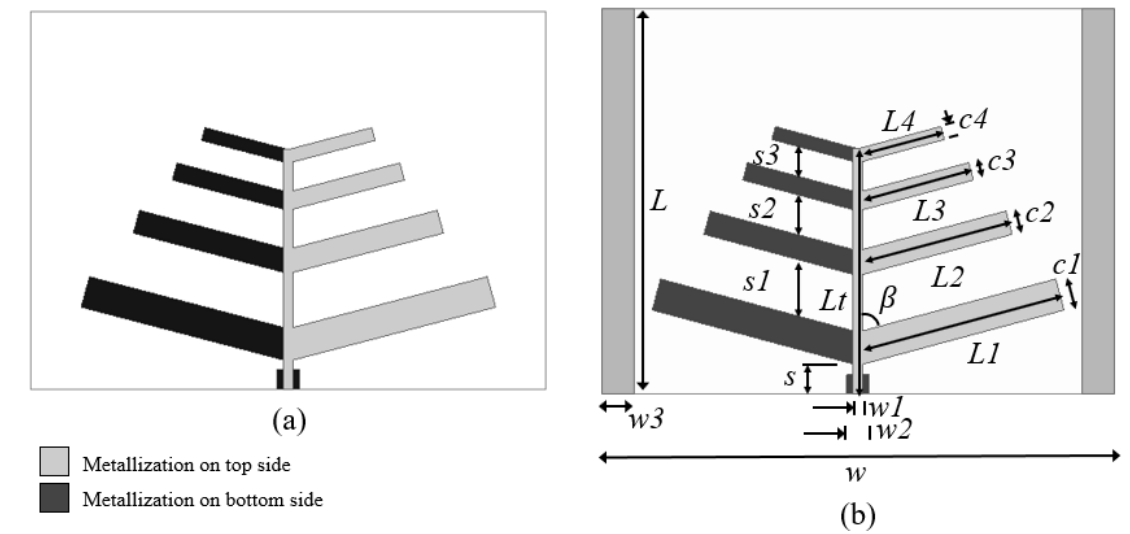
Figure 3. Straight connected log-periodic microstrip structures. ( a ) Antenna. ( b ) Proposed antenna sensor with two laterally placed wide strip parasitic elements.